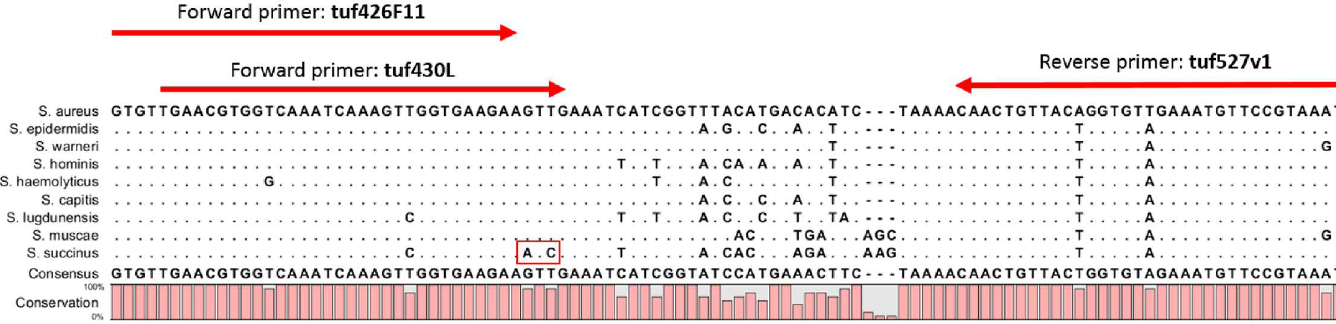
Fig 4. tuf gene amplicon region sequence alignment. The tuf gene ampliconsequencewas alignedwith seven clinicallyrelevant Staphylococcus species commonlydetected in human bloodstream infectionand two species used as suppressors in this study. The sequencesalignedfrom top to bottom are Staphylococcus aureus , Staphylococcus epidermidis , Staphylococcus warneri , Staphylococcus hominis , Staphylococcus haemolyticus , Staphylococcus capitis , Staphylococcus lugdunensis; Staphylococcus muscae and Staphylococcus succinus . The bpHDA amplification primers are shown on the top of the alignment (red arrows), which are perfect match with the corresponding regions of Staphylococcus aureustuf gene amplicon(the top sequencein the alignment). The two mismatch bases at the 3’ end flap of the forward primer tuf430L with Staphylococcus succinus ampliconare indicatedwithin the red rectangle(the bottom sequencein the alignment), which dramatically slows down the amplification rate of Staphylococcus succinus . The dots in the alignment indicateidenticalnucleotides with the top sequenceof Staphylococcus aureustuf gene ampliconin the